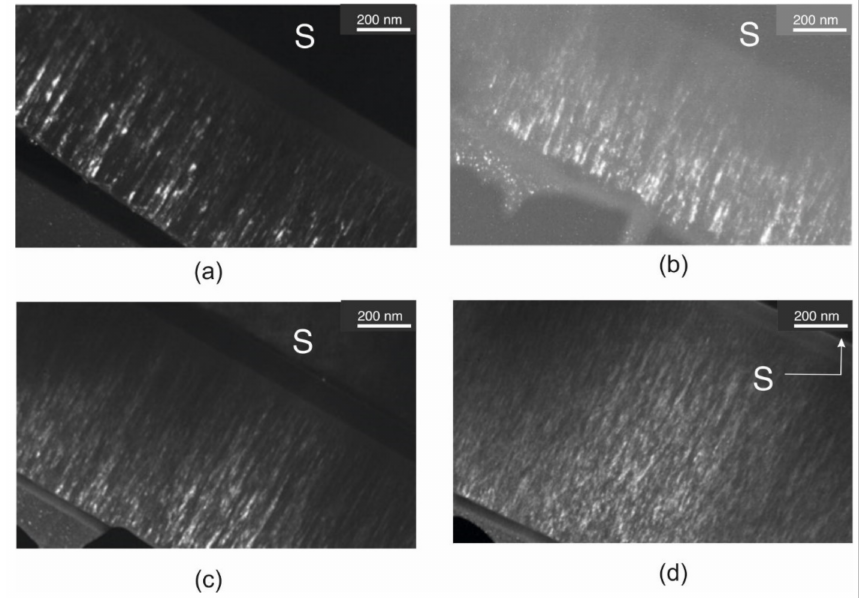
Figure 2. TEM images of coatings cross-sections for samples: ( a ) TiB 2 ; ( b ) Ti 0.78 W 0.22 B 2 ; ( c )